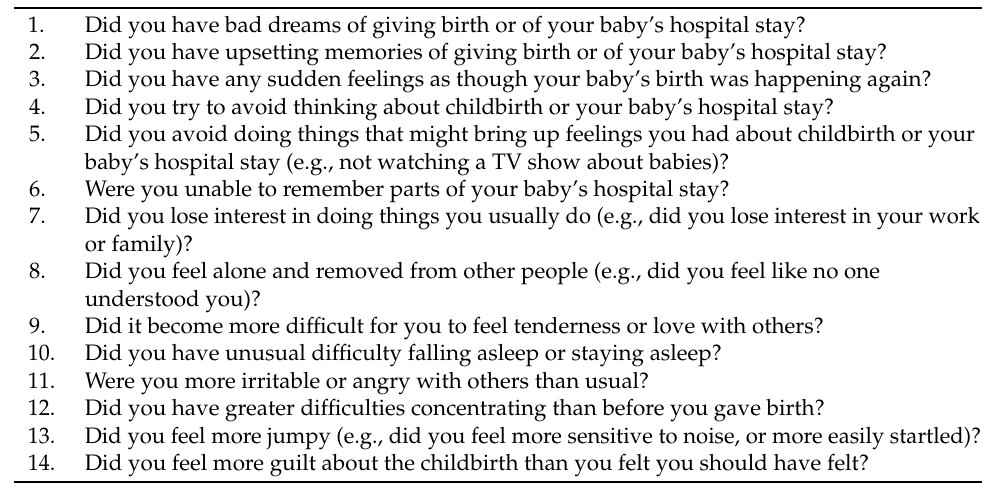
Table A1. Modified perinatal post-traumatic-stress questionnaire symptoms (modified